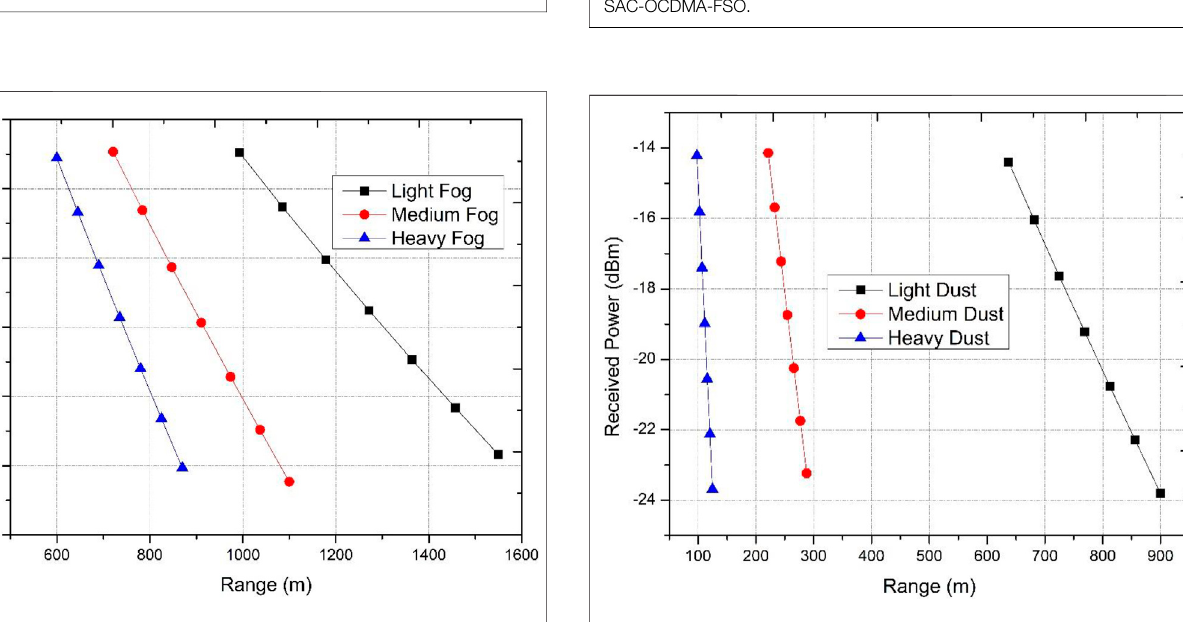
FIGURE 9 | Received power vs. range under different fog levels for OFDM/SAC-OCDMA-FSO.